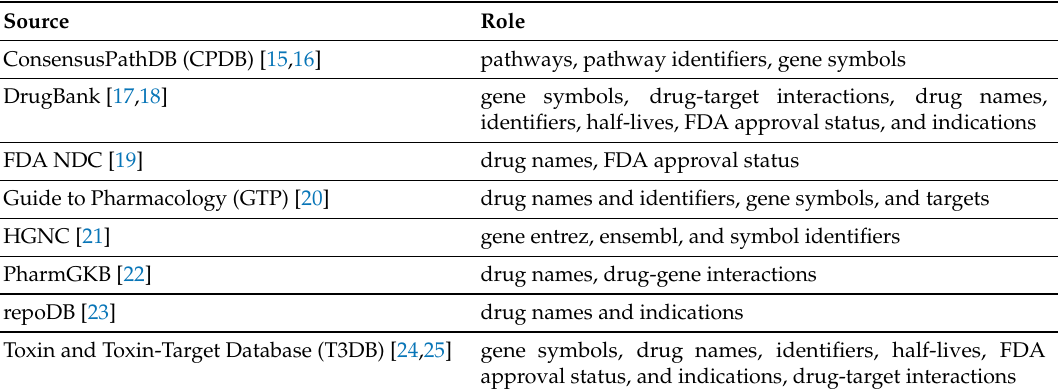
Table 1. The sources and their roles within the DRUGPATH